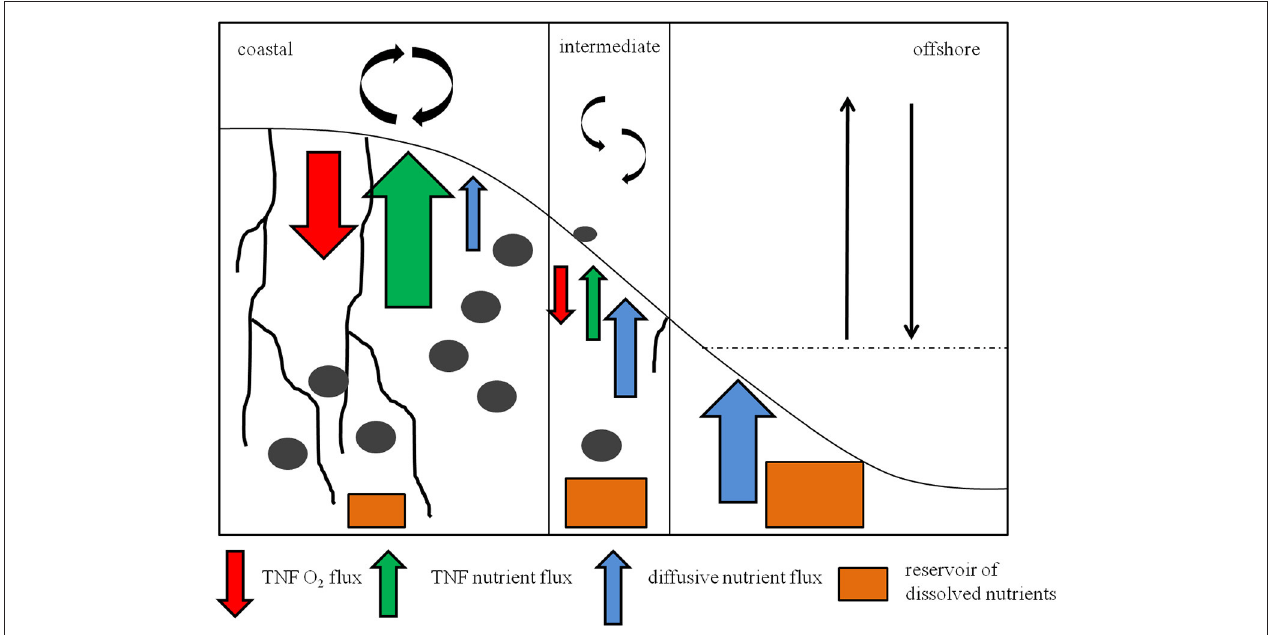
FIGURE 11 | Schematic overview of the sedimentary conditions and trends in fluxes at coastal, intermediate and offshore stations. Black irregular lines in the sediment symbolize deep burrowing tube- dwellers. Gray ellipses symbolize burrowing animals. The red arrows mean the total net flux of O 2 to avoid misunderstandings, green arrows mean the TNF of nutrients, blue arrows mean the diffusive flux of nutrients. Orange boxes stand for the nutrient inventory inside the sediment. The size of these symbols stands for the high of the fluxes and the size of the nutrient inventories in the